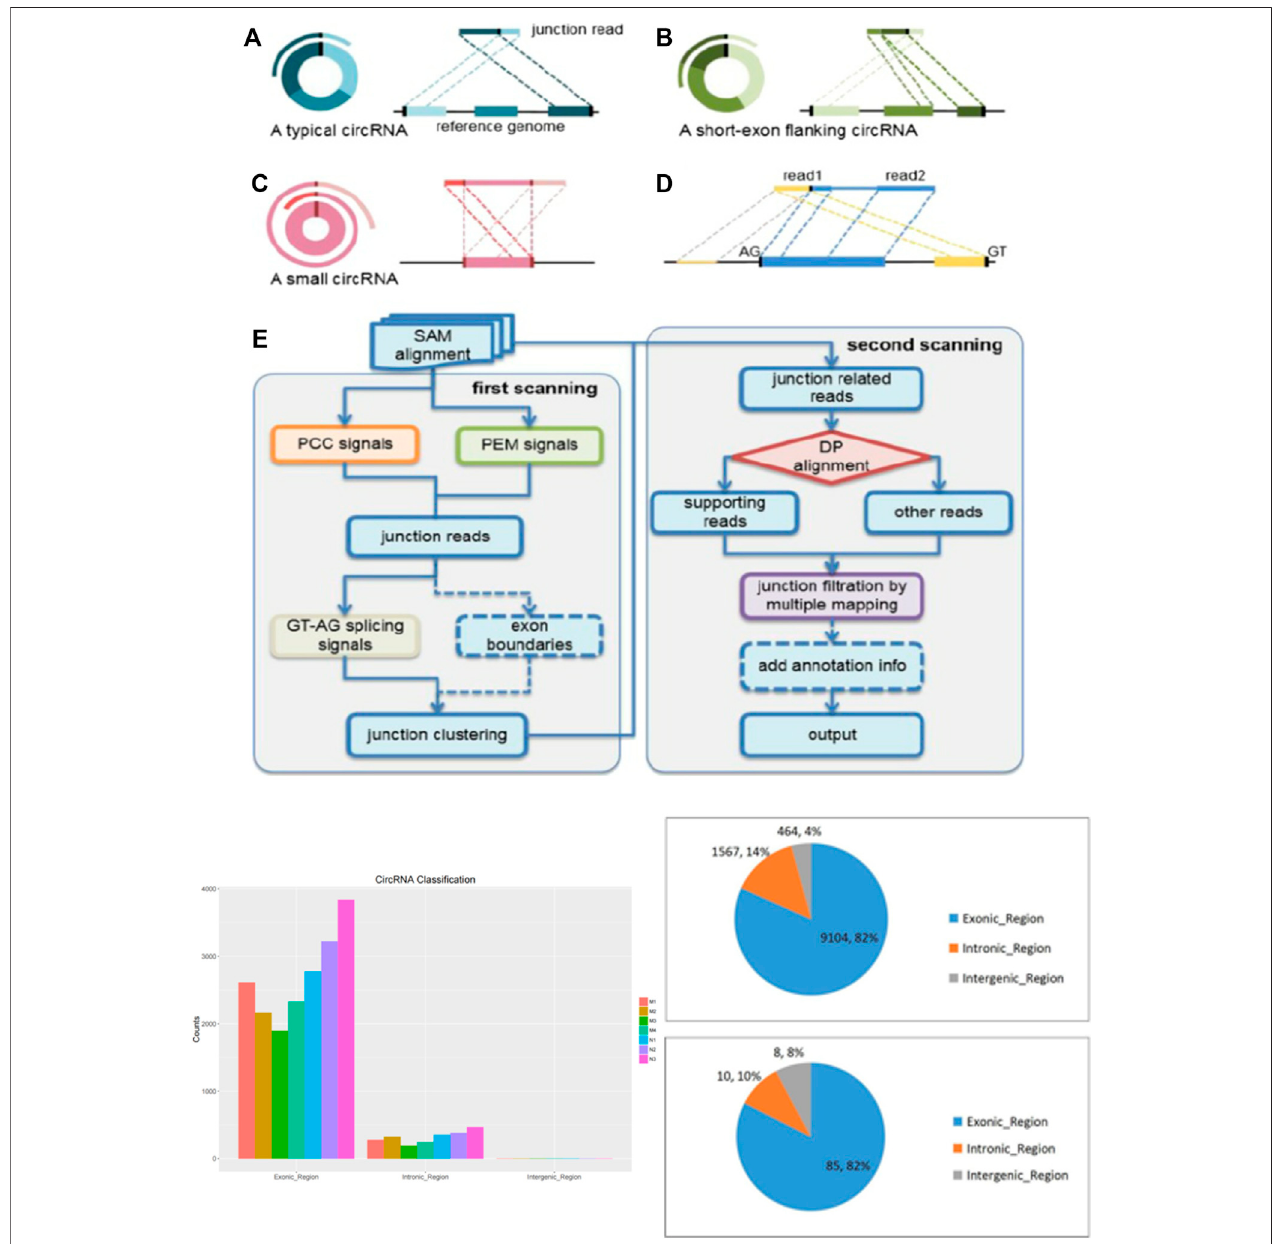
FIGURE 1 | The description of cirRNA and high-throughput